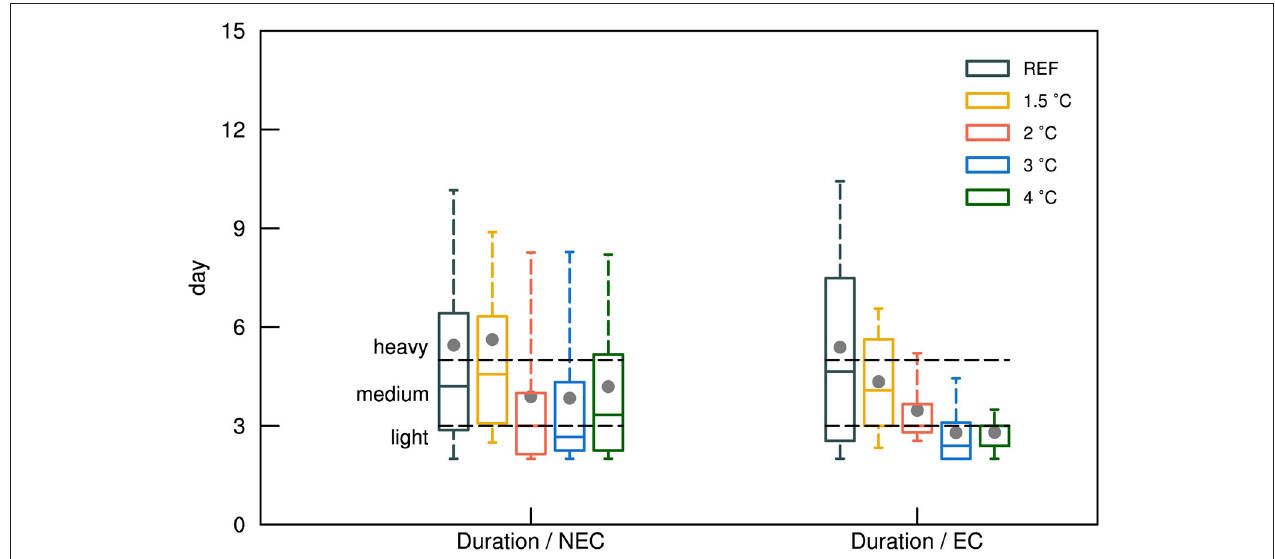
FIGURE 12 | Boxplots of chilling damage duration (unit: day) during the reference time period (1986–2005) and for 1.5, 2, 3, and 4 ◦ C warming levels in the future by LMDZ-MME over Northeast China and Central and East China. The top and bottom whiskers are the 10th and 90th percentiles. The black dotted lines indicate the corresponding rank of